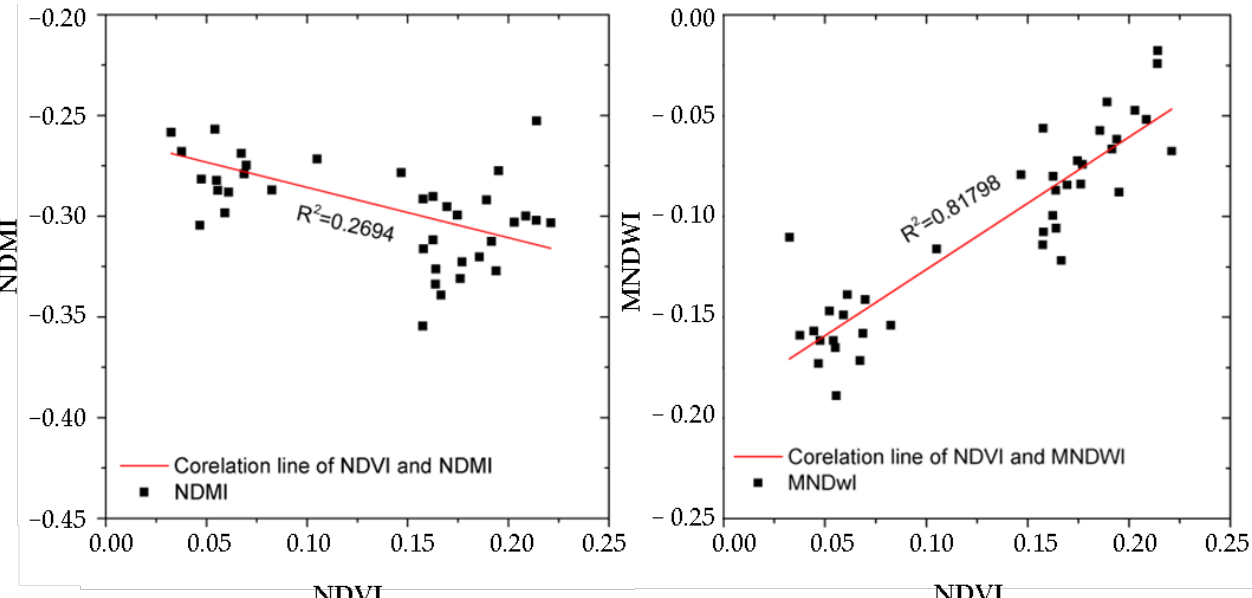
Figure 10. Correlation graphs between NDVI and NDMI and MNDWI.